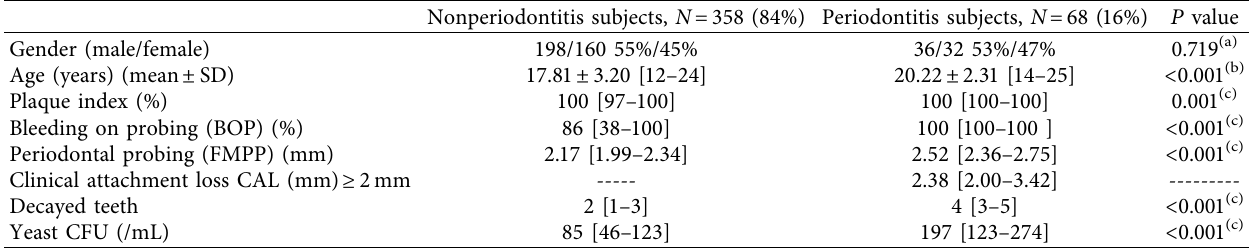
Table 1: Demographic and clinical characteristics and the presence of yeast in the nonperiodontitis and periodontitis groups.